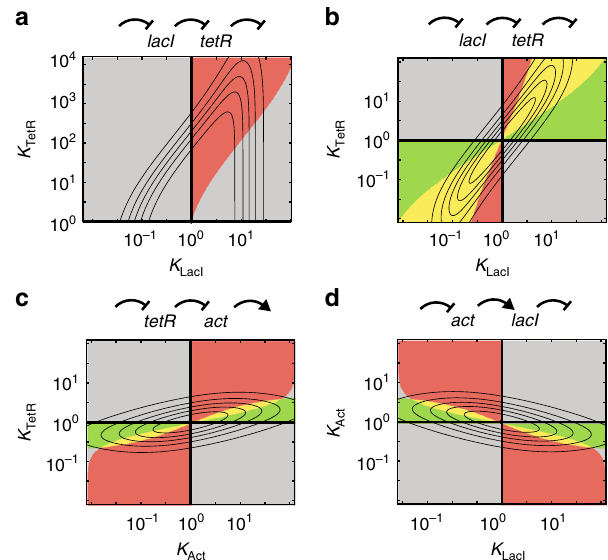
Fig. 5 Generality of epistasis domain organisation. Epistasis domains computed for alternative cascade organisations. a Epistasis domains for exchanged tetR – lacI order ( tetR now downstream), for full input range (0 – 100 µ M arabinose) determined using a biochemical cascade model (Methods section). b Same as for a , using a restricted input range (50 – 100 µ M arabinose). a and b show qualitatively the same domain organisation